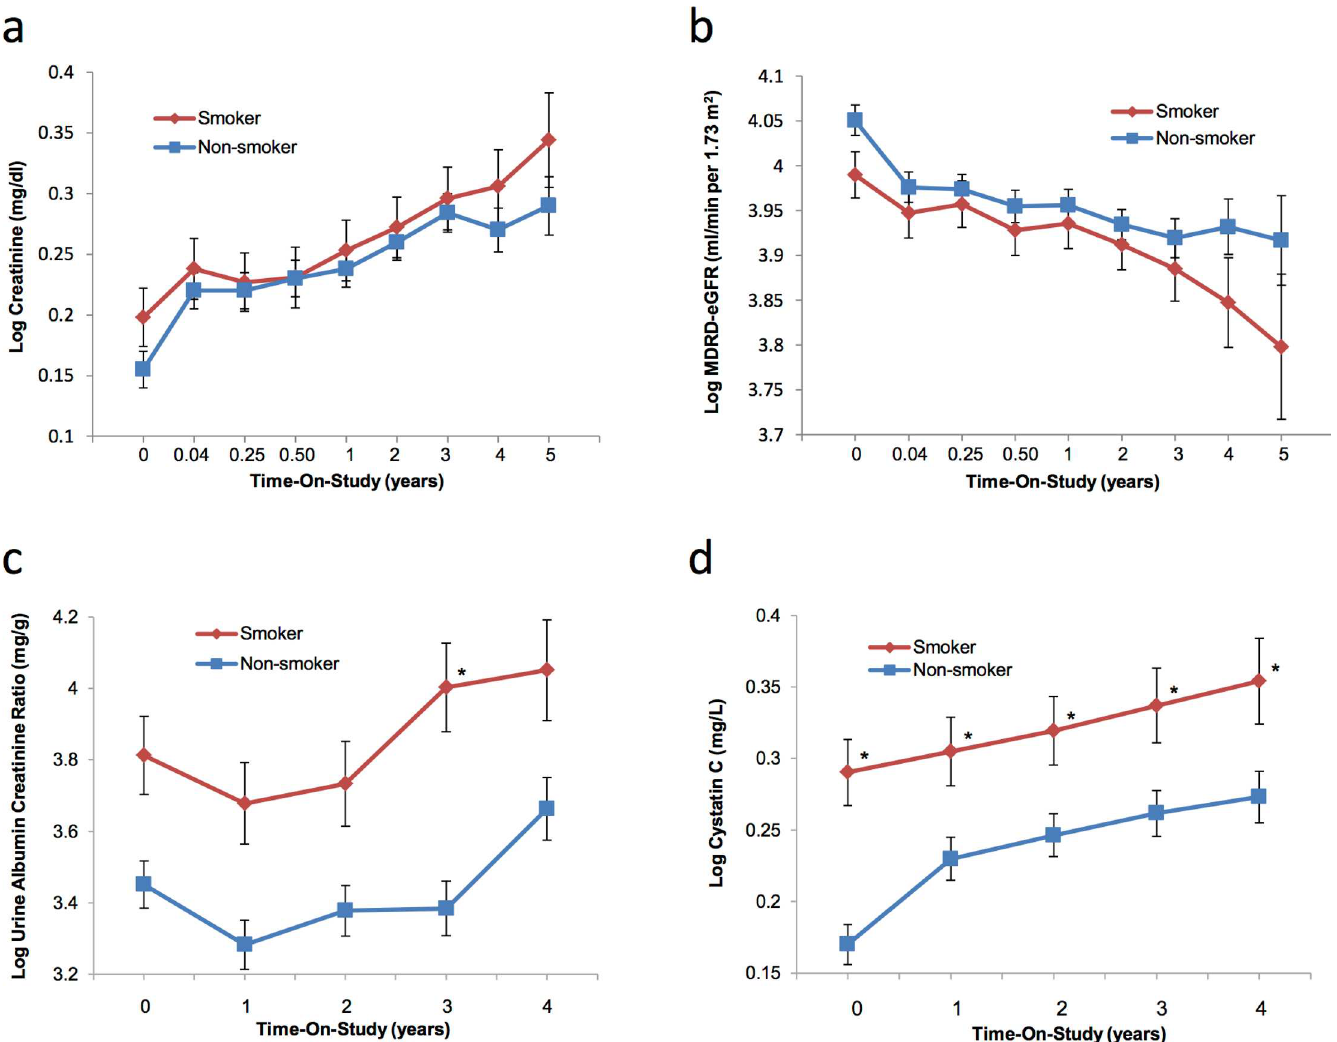
Fig 4. Longitudinal analysis of the effect of smoking on kidney function. Least square means measuredover time-in-study are delineated by smoking status, and the panelsdisplay the following:a): log values of the means for creatinine (mg/dL); b): log values of the means for MDRD-eGFR (mL/min per 1.73m 2 ); c): log values of the means for Urine Albuminto CreatinineRatio (mg/g); and d): log values of the means for Cystatin C (mg/L). An asterisk ( * ) indicates the mean for smokers is significantly different than non-smokers value at same time point (p < 0.05).